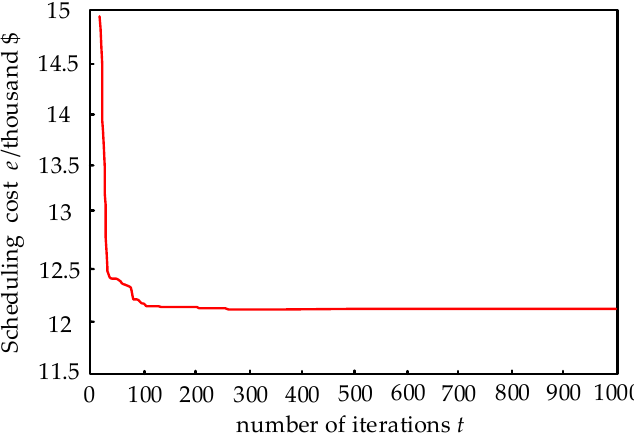
Figure 13. The change curve of economic costs with the number of iterations (improved SPSO).